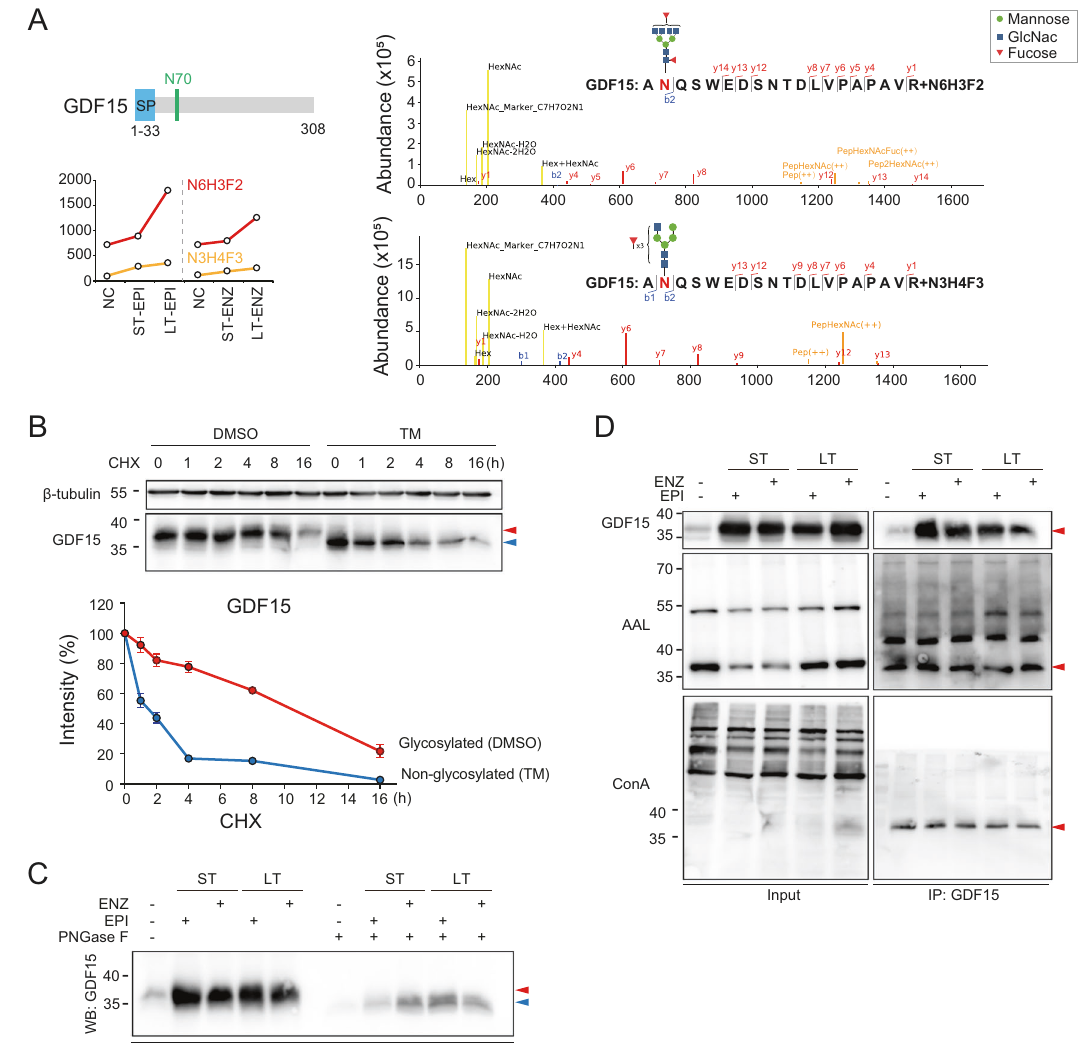
Fig. 3 GDF15 is glycosylated at amino acid N70. A Levels of N6H3F2 and N3H4F3 glycan at GDF15 N70 are increased in CRPC cells. SP, signal peptide. Putative NQS motif in GDF15 is labeled in green. Numbers indicate amino-acid positions (left panel). MS spectrograms and fragment ion features of IGPs are shown (right panel). For each N -glycosylation site, one representative higher-energy collision dissociation (HCD) MS 2 spectrum is shown to exemplify its identi fi cation based on detection of b and y ion (de fi ning its peptide sequence by fracture mode of HCD). B Level of GDF15 protein is measured by WB in LNCaP cells in the presence or absence of 20 µm cycloheximide (CHX). Error bars indicate std. of biological triplicates. C GDF15 immunoprecipitants were treated with PNGase F and analyzed by WB. D Cell lysate (input) and GDF15 immunoprecipitant were used for lectin detection with Con A and AAL antibodies. Con A and AAL detect mannose and fucose, respectively. Red arrows point to glycosylated GDF15 and blue arrows point to non-glycosylated